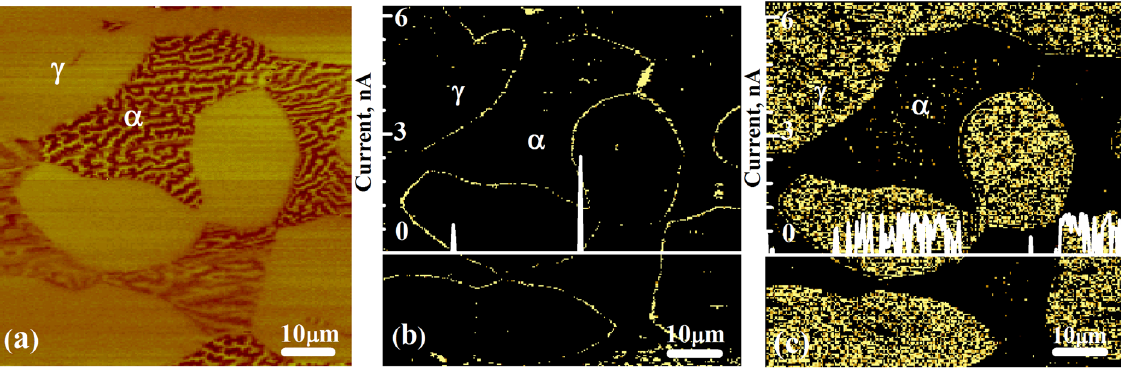
Figure 1. ( a ) MFM image before hydrogen charging, and corresponding conductive maps (in nA) with line current profiles for the passive films without hydrogen ( b ) and with hydrogen ( c ) on the same region as MFM